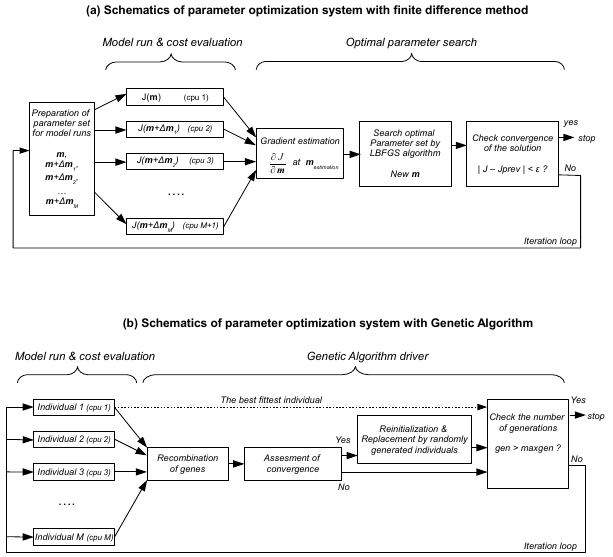
Fig. 2. Schematics of a parameter optimization system with (a) fi- nite difference method and (b) genetic algorithm. See text for de-